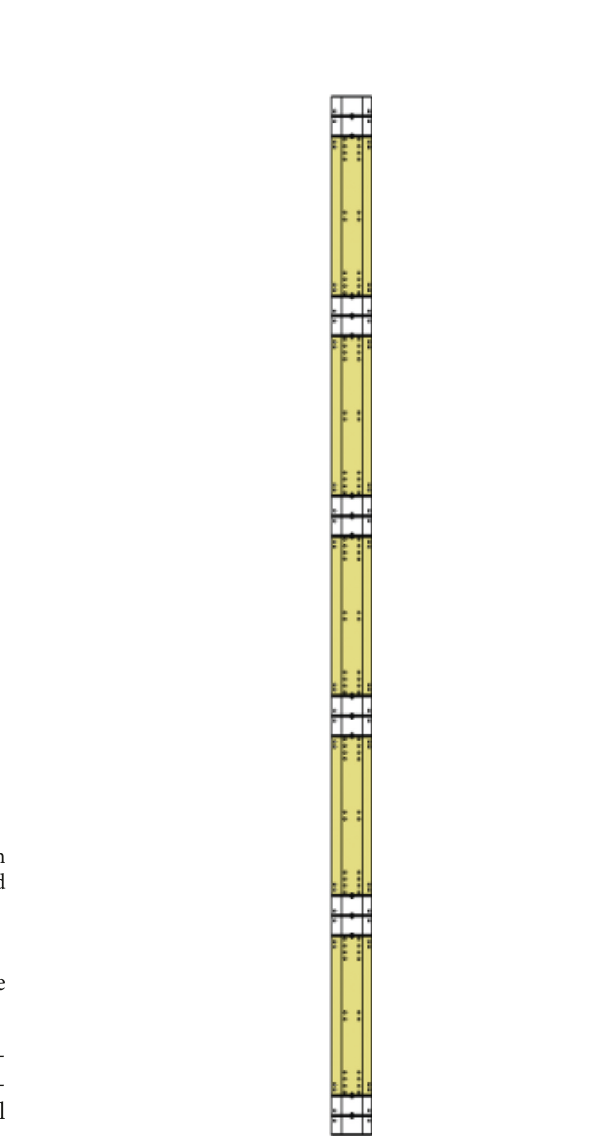
Figure 13: Column with a total length of